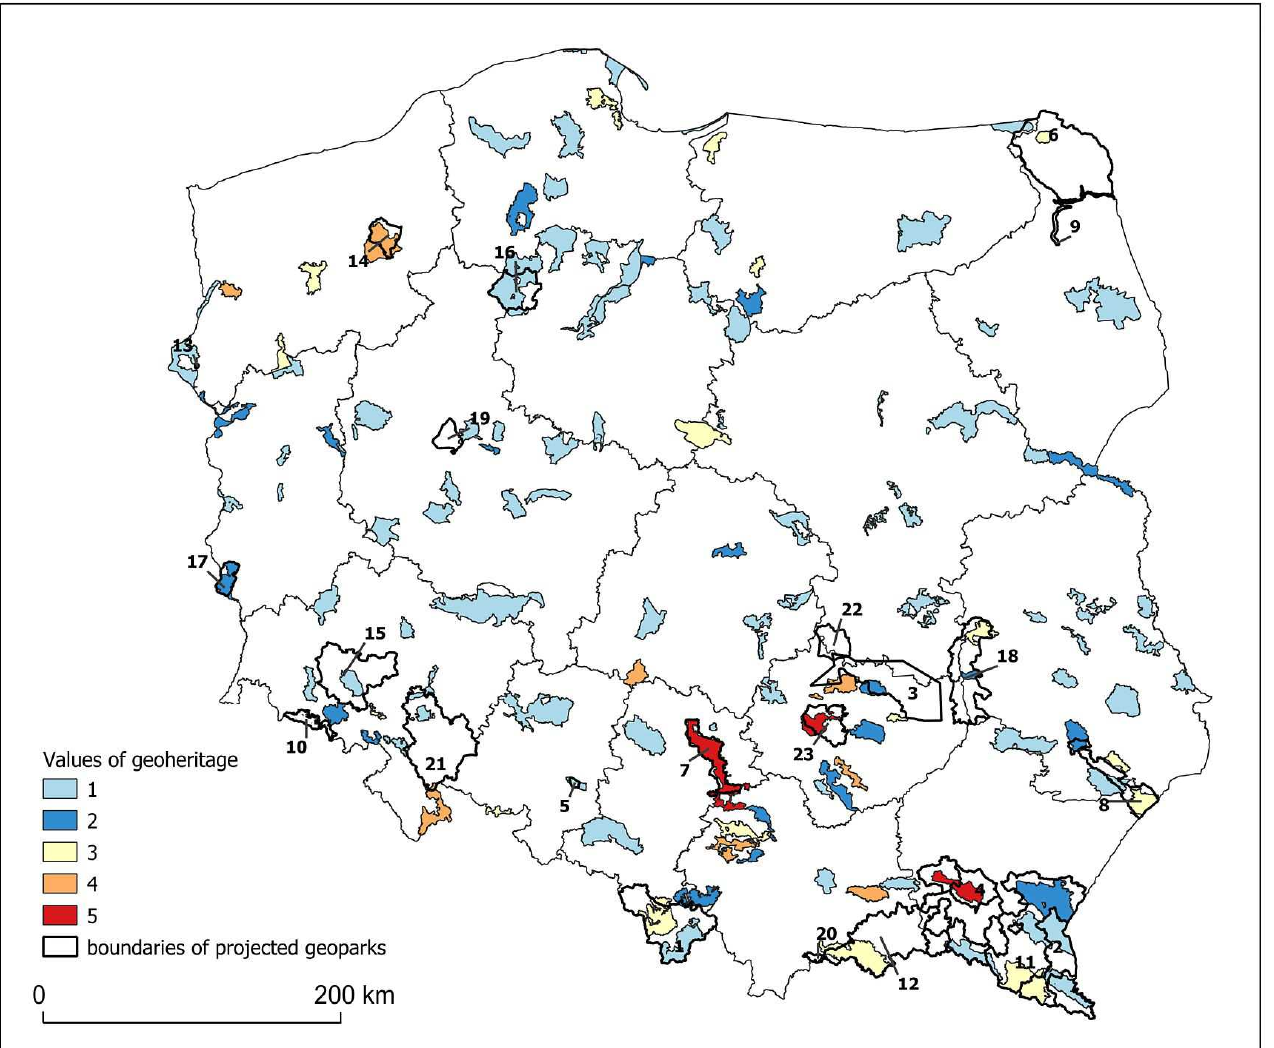
Figure 5. The results of landscape park assessment against the network of the planned geoparks. Category of resources (1) very small, (2) small, (3) moderate, (4) large, (5) very large. Planned and existing geoparks. 1—Beskid ´Sl ˛asko-Morawsko- ˙Zywiecki, 2—Bieszczady